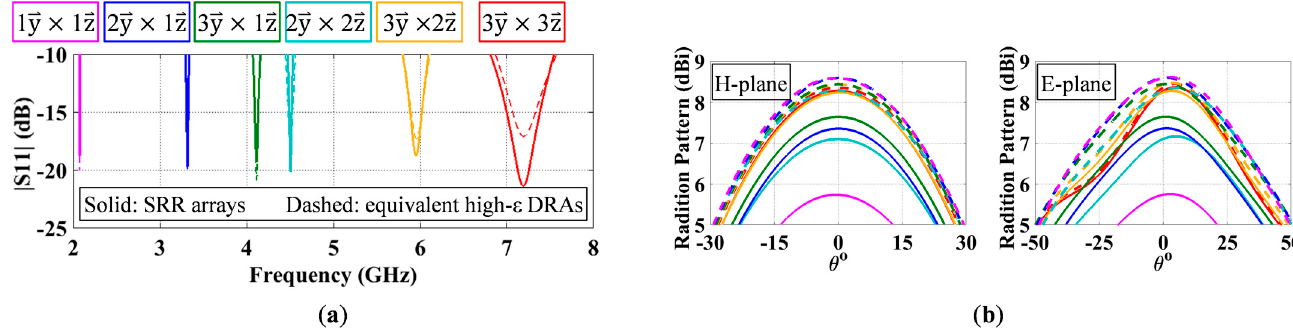
Figure 3. ( a ) S11 results of SRR arrays (solid) with different SRR arrangements and their correspond- ing equivalent high- ε DRAs (dashed). ( b ) E- and H-plane radiation patterns of SRR arrays with different SRR arrangements (solid: realized gain; dashed: directivity). Different colors represent different SRR arrangements: